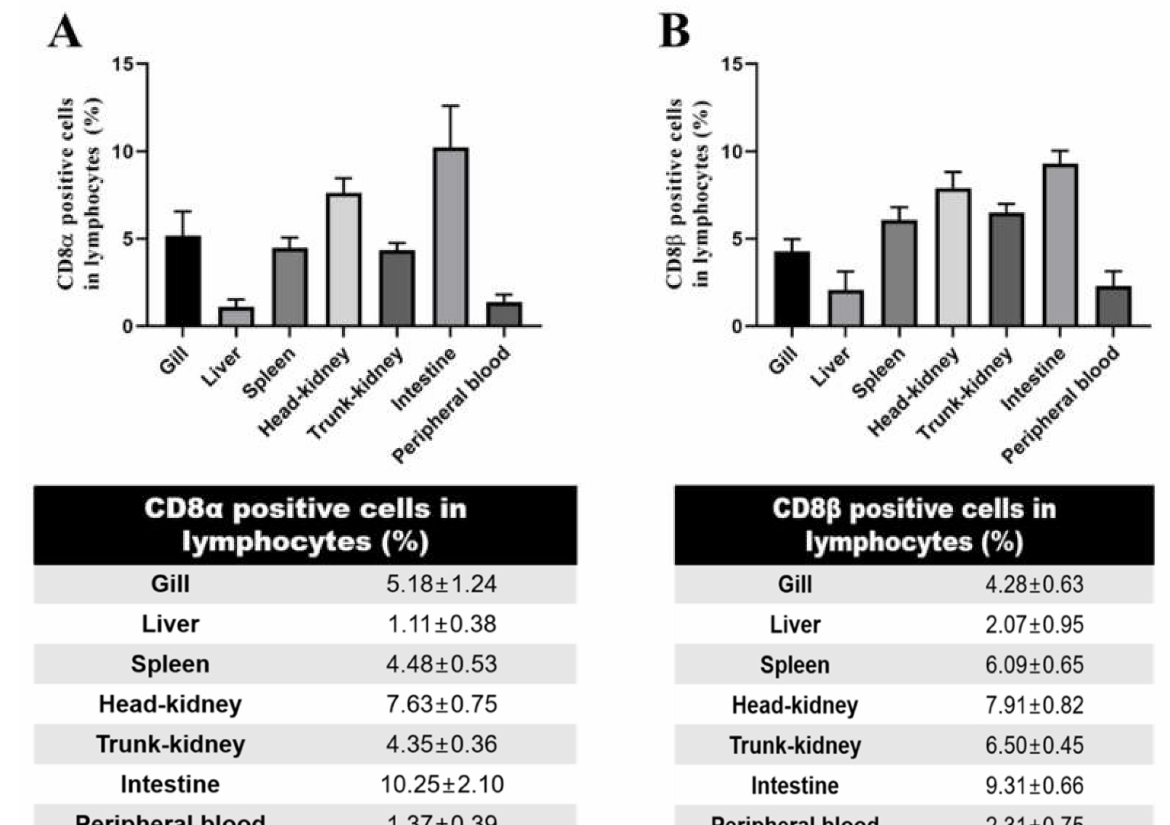
Figure 5. Staining pattern of 3H9 and 1G7 mAbsof leukocytes in different tissues analyzed by flow cytometry. Leukocytes isolated from gill, liver, spleen, head-kidney, trunk-kidney, intestine and peripheral blood were stained with anti-CD8 α mAb (3H9) ( A ) or anti-CD8 β mAb (1G7) ( B ), followed by FITC. Percentages of CD8 α - andCD8 β -positive lymphocytes in different tissues, represented as the mean ± SD of at least five